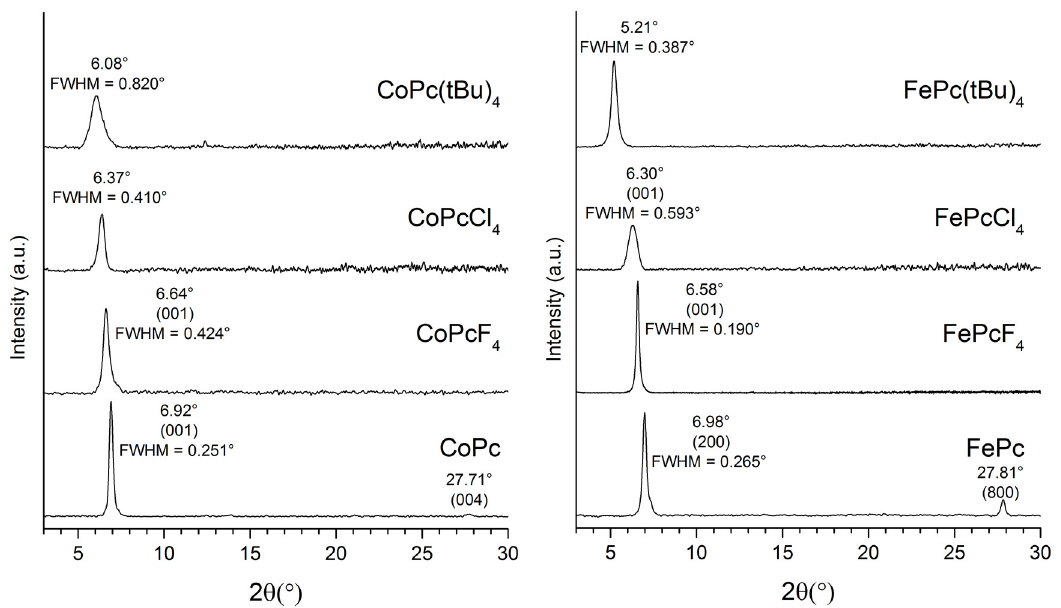
Figure 5. XRD patterns of CoPcR 4 and FePcR 4 (R = H, F, Cl, tBu) films.